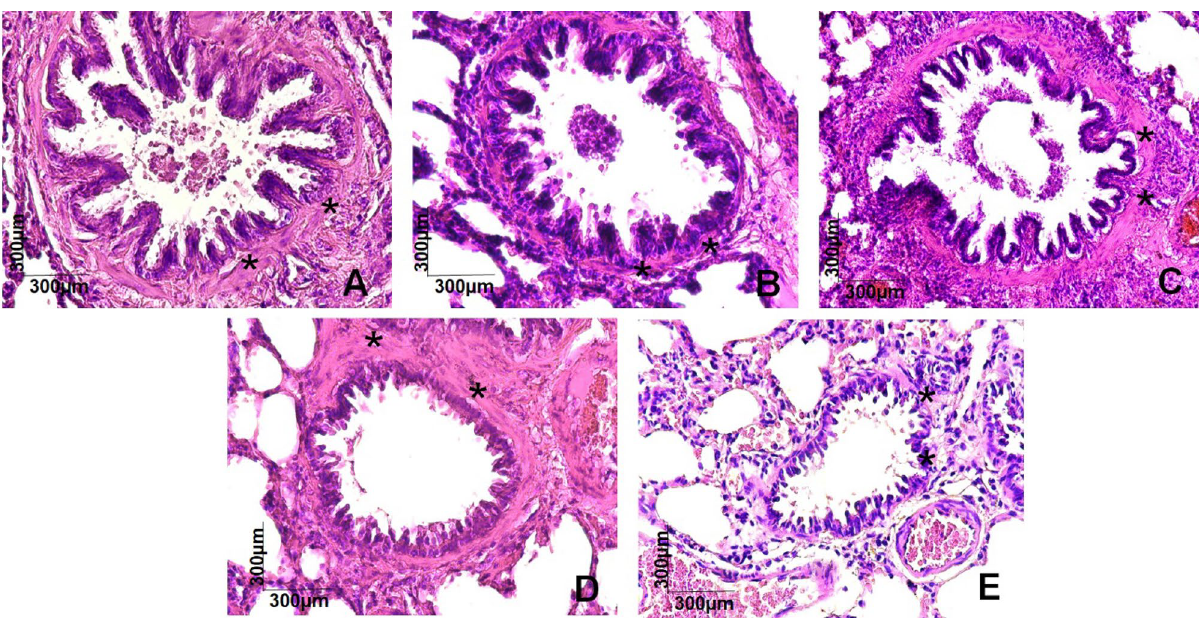
Figure 12. Photomicrograph of smooth muscle of terminal bronchioles of rats from the Ctrl ( A ), Ob ( B ), Asth ( C ), Ob + Asth ( D ) and Ob + Asth + Dexa ( E ) stained with HE. Smooth muscle